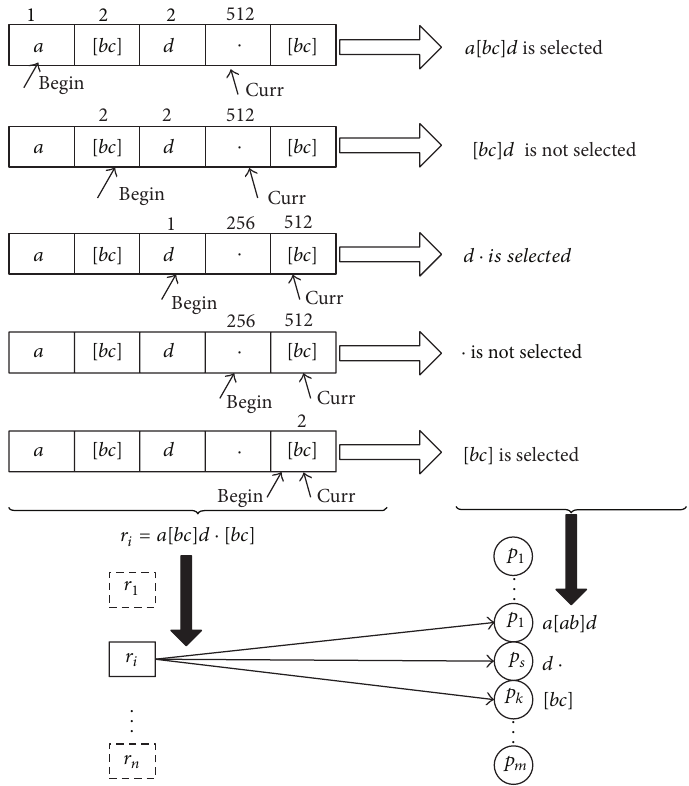
Figure 2: Process of generating print 𝑝 𝑖 from 𝑟 𝑖 .